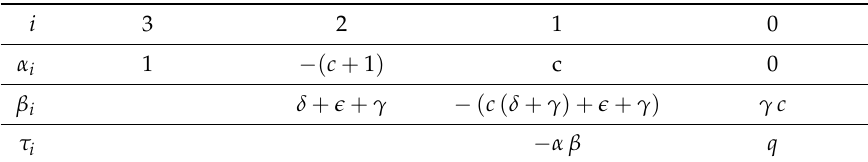
Table 1. Tabulated values for parameters α i , β i , and τ i which would transform Equation (78) to the canonical form of the Heun